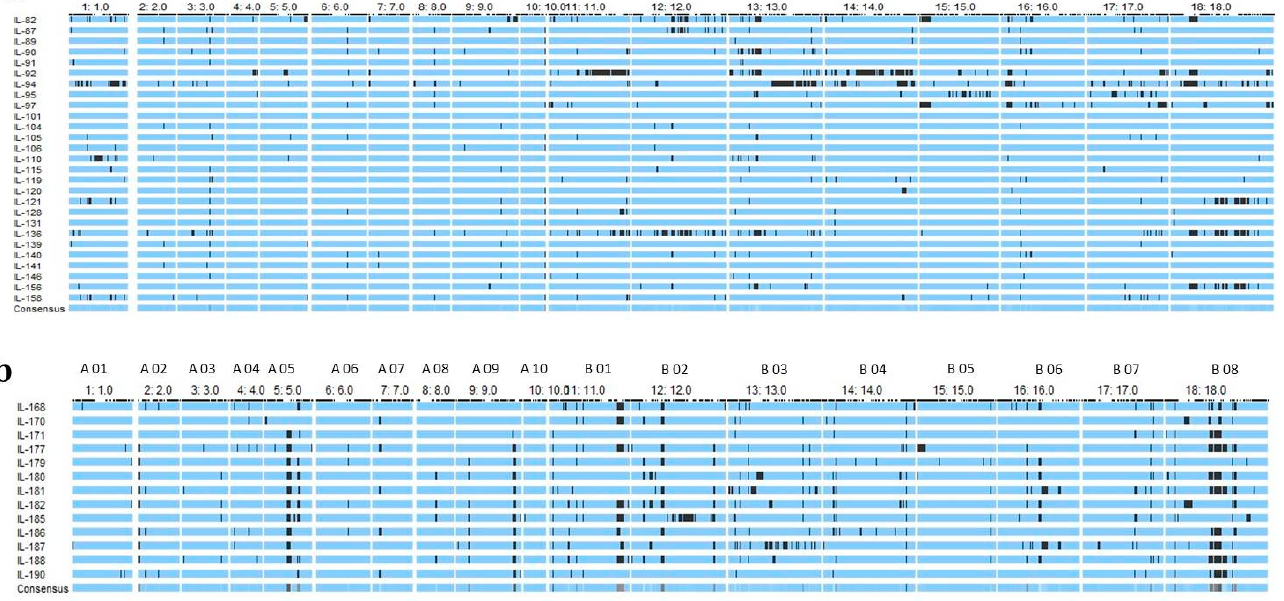
Figure 4. Introgressed segments of B. carinata into sub-genomes of B. juncea cultivars, viz., DRMRIJ 31 (D31_ILs) and Pusa Mustard 30 (PM30_ILs).